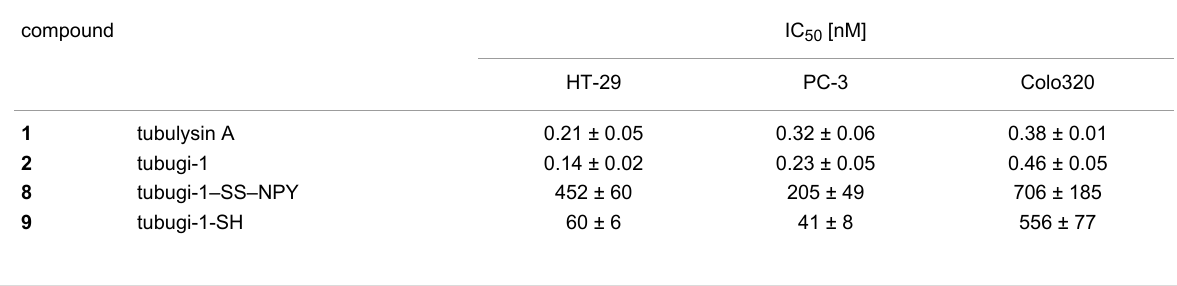
Table 1: IC 50 values [nM] of the reference and linker-modified toxin against HT-29, PC-3 and Colo320 cell lines.